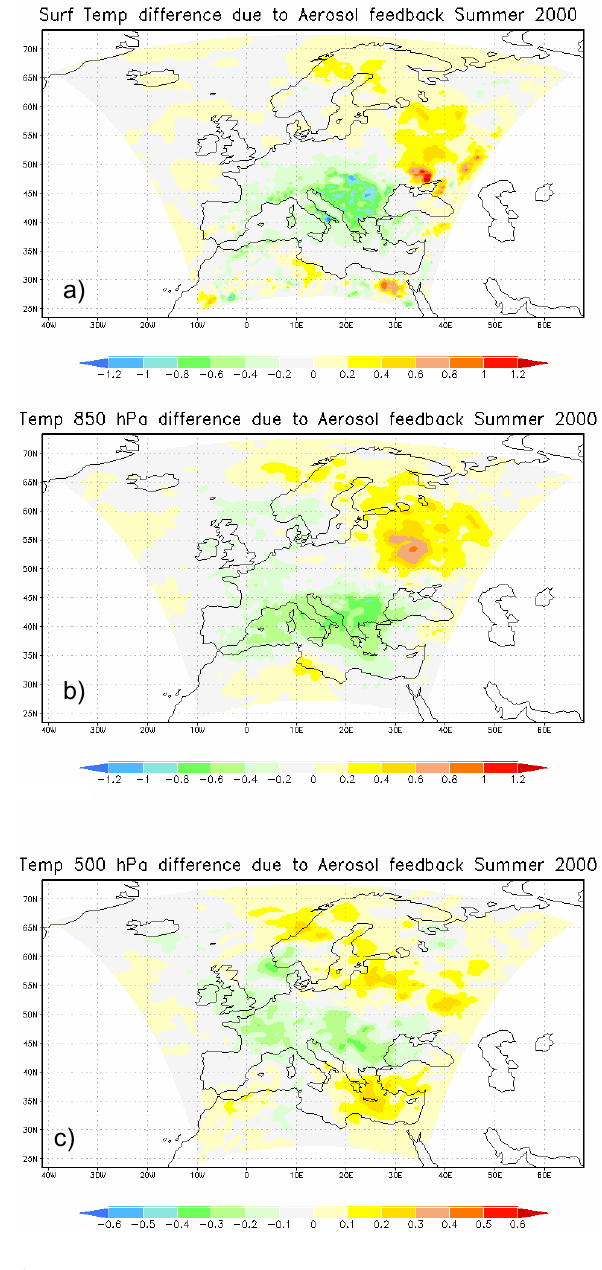
Figure 4. Seasonal mean fields in summer for the year 2000 of the difference AFrun-Crun Fig. 4. Seasonal mean fields in summer for the year 2000 of the Figure 3. Average streamlines in summer 2000 for a) 850 hPa, b) 500 hPa and c) 300 difference AFrun-Crun RegCM3/aerosol simulations due to aerosol Fig. 3. Average streamlines in summer 2000 for (a) 850hPa, RegCM3/aerosol simulations due to aerosol feedback in a) near surface air temperature feedback in (a) near surface air temperature (deg ◦ C), (b) air tem- (b) 500hPa and (c) 300hPa. The color-bars denote the wind speed hPa. The color-bars denote the wind speed (m/s). Mind the different color-scale for the (deg o C), b) air temperature at 850 hPa (deg o C) and c) air temperature at 500 hPa (deg perature at 850hPa (deg ◦ C) and (c) air temperature at 500hPa (deg (m/s). Mind the different color-scale for the different pressure lev- ◦ C). Mind the different color-scale for temperature differences at els. different pressure levels. o C). Mind the different color-scale for temperature differences at 500 hPa.